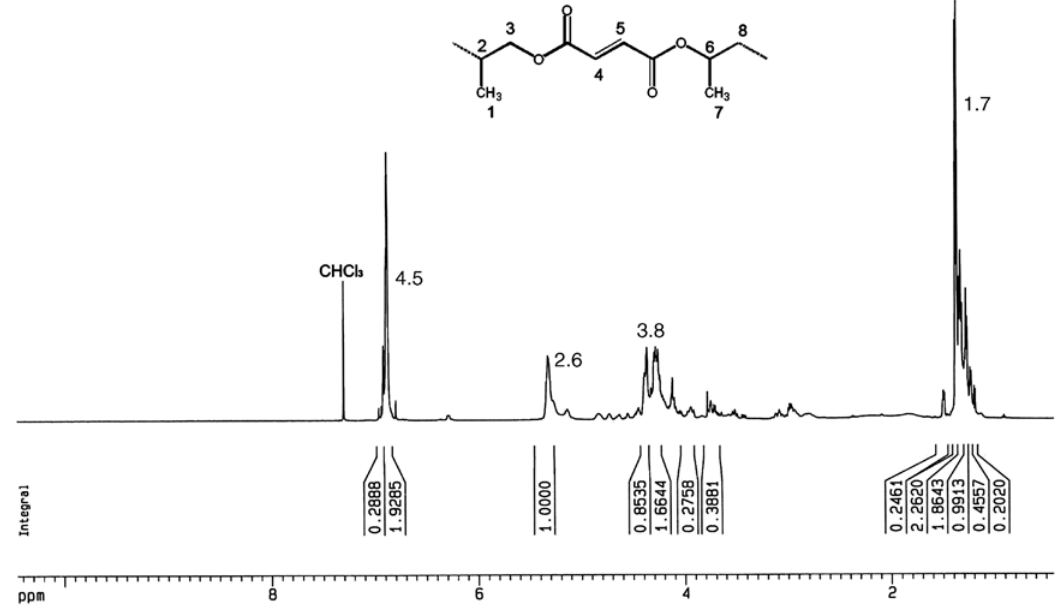
Figure 1 A representative proton NMR spectrum of purified PPF.